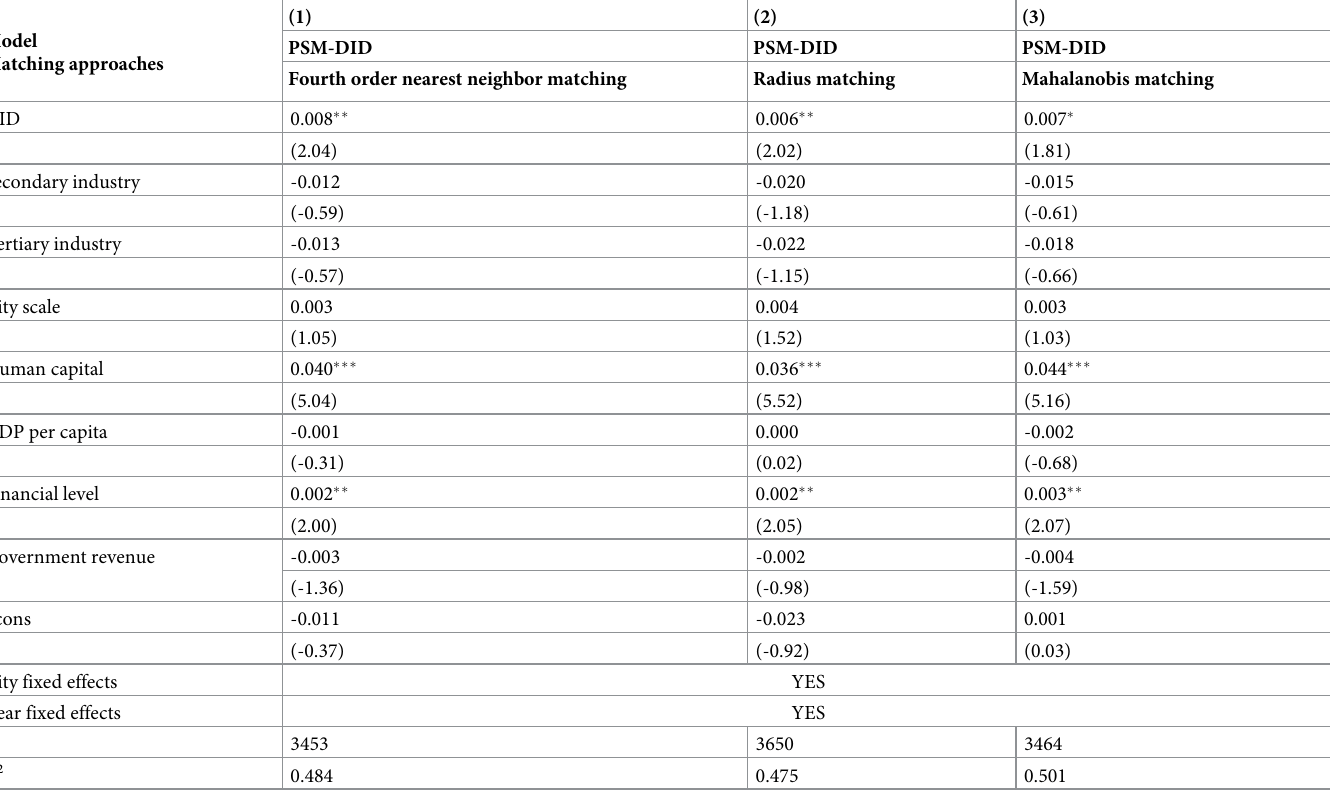
Table 5. Robustness of test results based on different approaches to matching (Explained variable: Public services). Model Matching